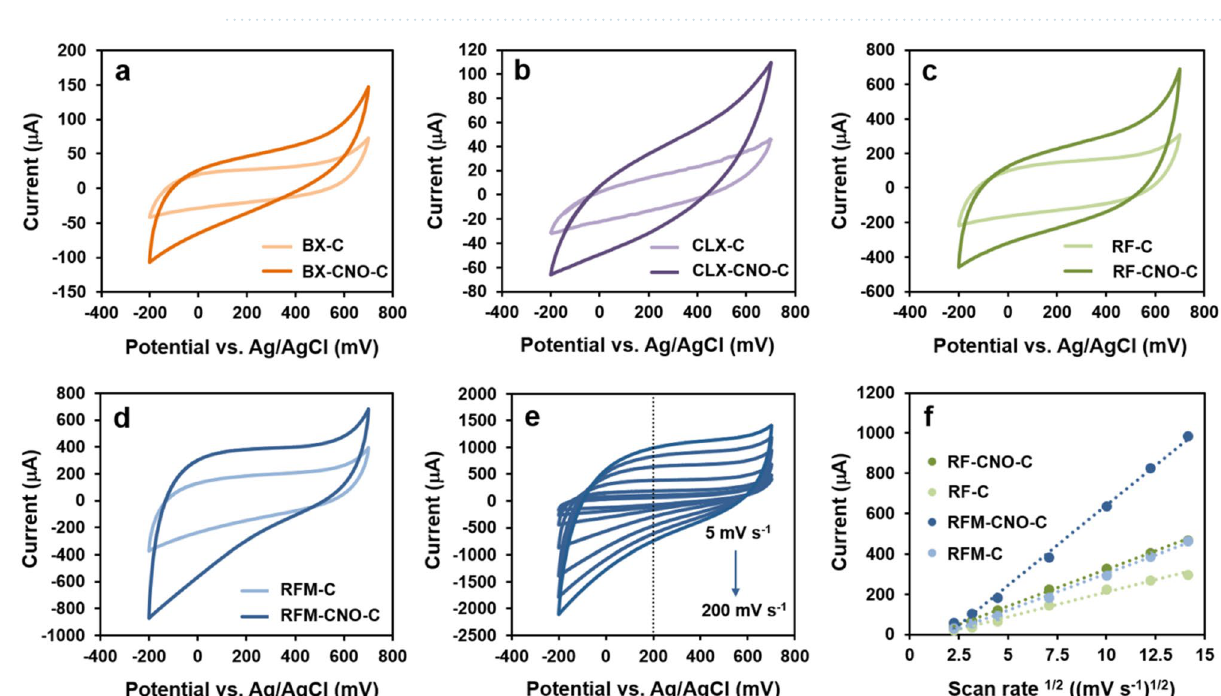
Figure 9. CV measurements were performed in a three-electrode configuration. ( a – d ) CV curves of all synthesized materials after pyrolysis recorded in 0.1 M KOH at 50 mV s −1 . ( e ) CV curves recorded at the different scan rates for RMF-CNO-C . ( f ) Dependence of the current vs. the square root of the scan rate for the selected